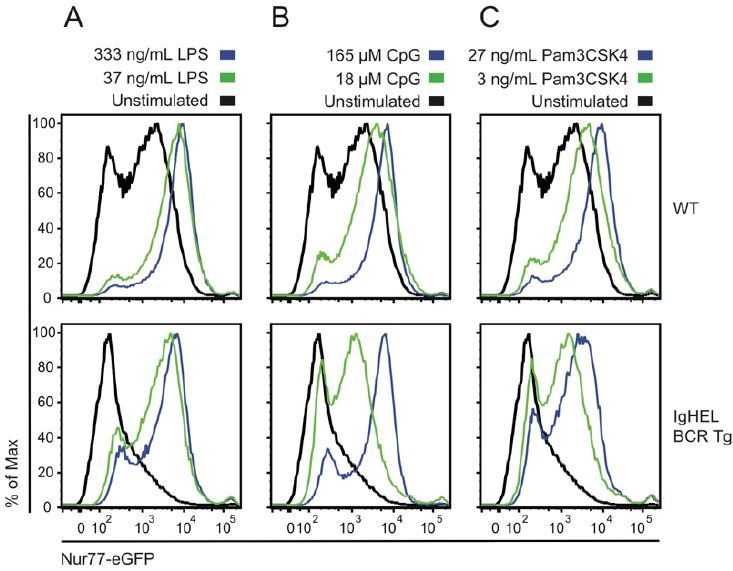
Naïve B cells are competent to upregulate Nur77-eGFP in response to canonical TLR ligands even in the absence of endogenous antigen.Splenocytes from non-BCR Tg and IgHEL BCR Tg reporter mice were stimulated overnight with low and high doses of ligands for TLR4 / rp105 (A), TLR9 (B), and TLRs1/2 (C). Histograms depict GFP fluorescence in B220+ splenocytes. As previously reported, Nur77-eGFP expression is low in the absence of endogenous antigen (IgHEL BCR Tg), but these cells are nevertheless responsive to a broad range of TLR ligands.